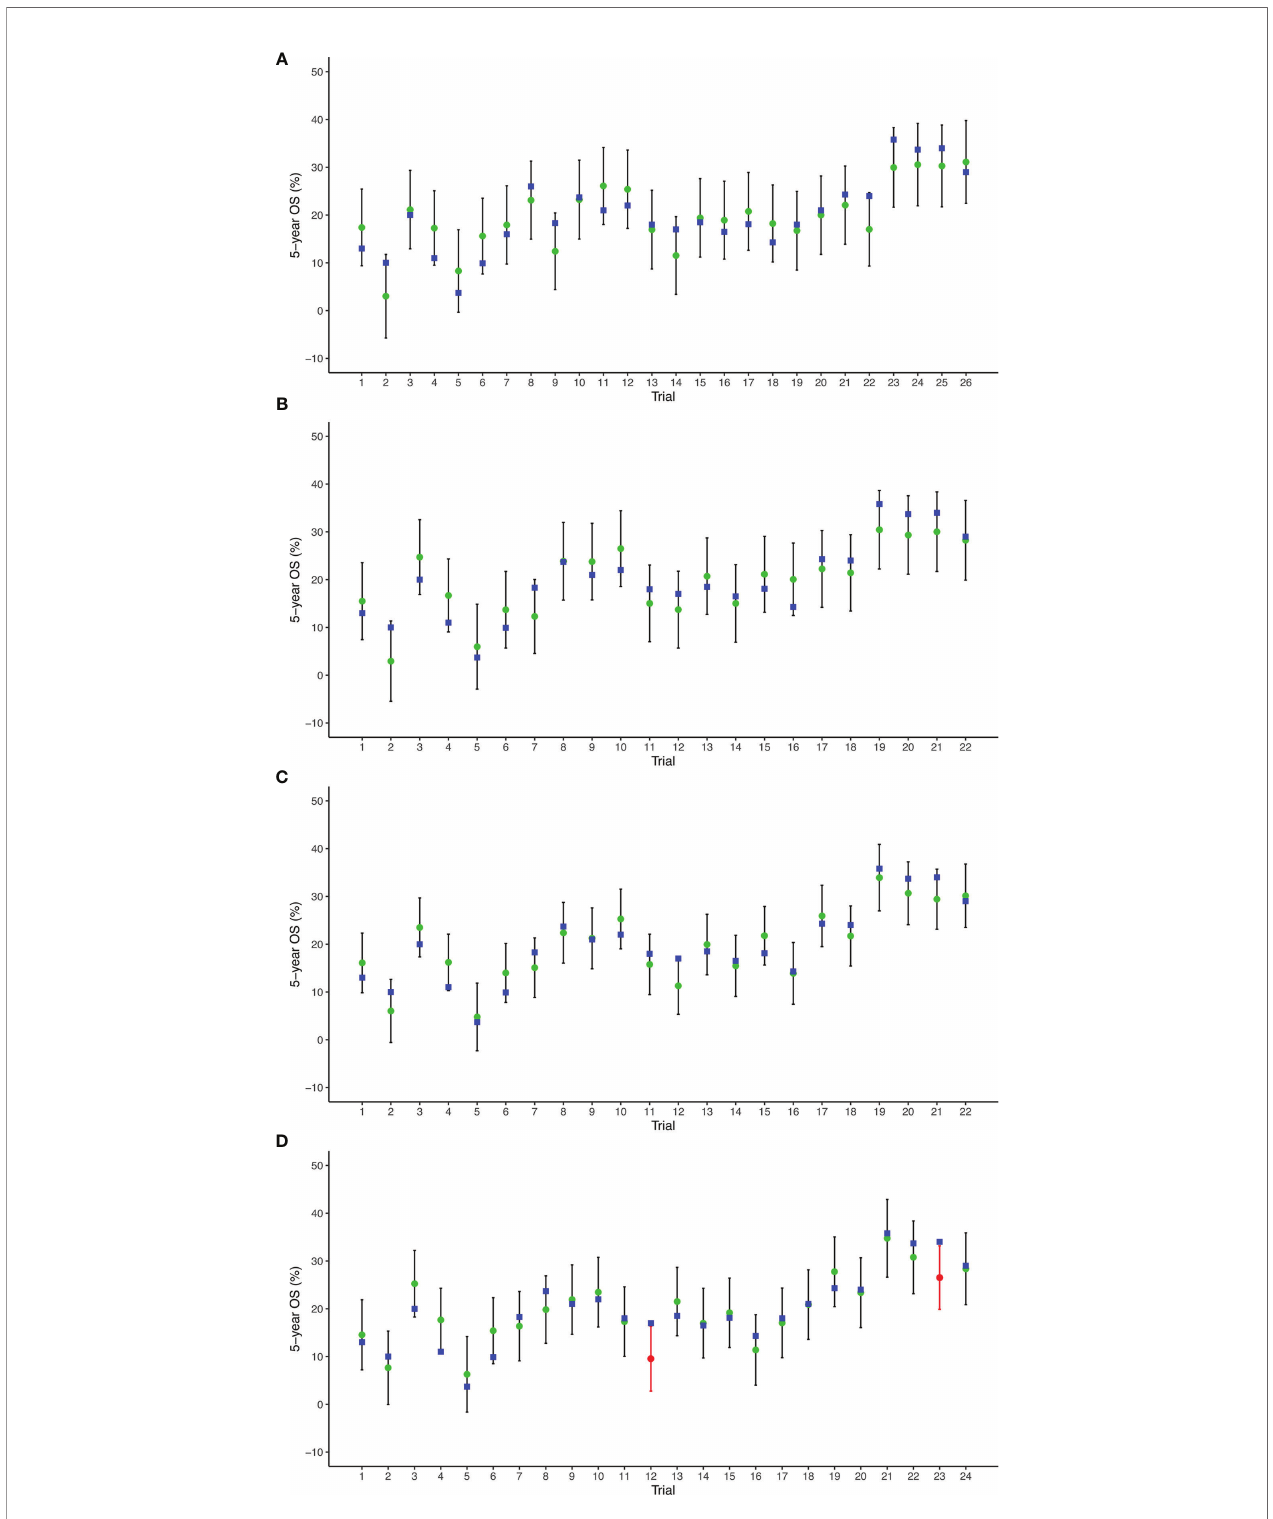
FIGURE 4 | Leave-one-out cross-validation analysis of the prediction of 5-year OS based on 2-year PFS/TTP (A) , 3-year PFS/TTP (B) , 4-year PFS/TTP (C) , and 5- year PFS/TTP (D) . Green circles represent predicted 5-year OS, vertical lines for 95% prediction intervals, and blue squares for observed 5-year OS. Red circles and lines indicate that observed 5-year OS is beyond the 95% prediction intervals. OS, overall survival; PFS/TTP, progression-free survival/time to